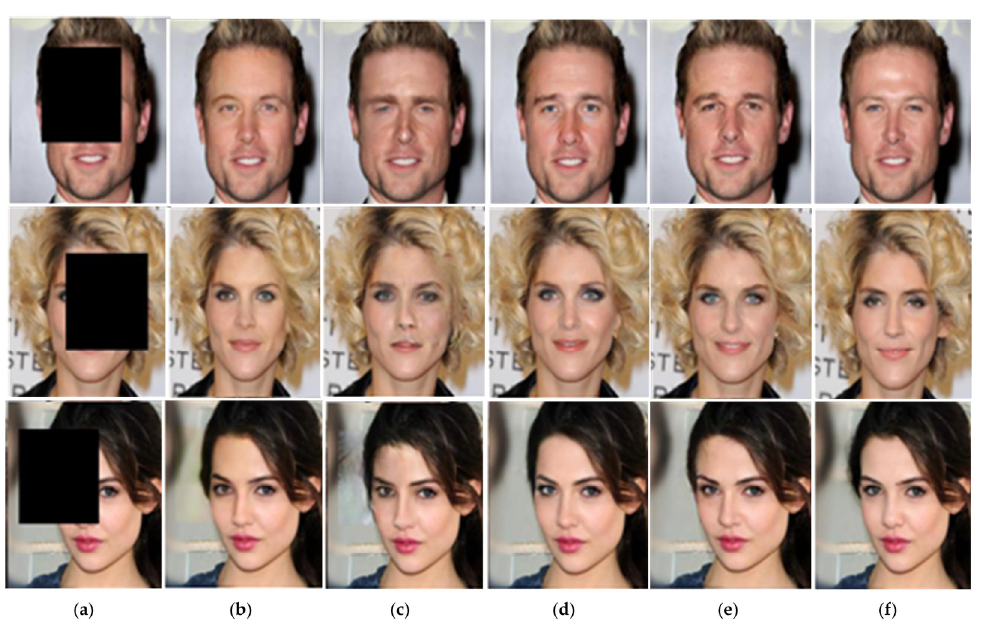
Figure 12. C omparison of di ff erent methods on the free-form masked images. ( a ) Input images of the network; ( b ) Results of CE; ( c ) Results of GCA; ( d ) Results of PEPSI; ( e ) Results of Ours; ( f ) Ground truth.